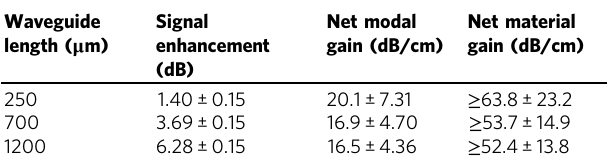
Table 1 Gain characteristics of the 250, 700, and 1200 μ m long hybrid slot waveguides Waveguide length ( μ m)